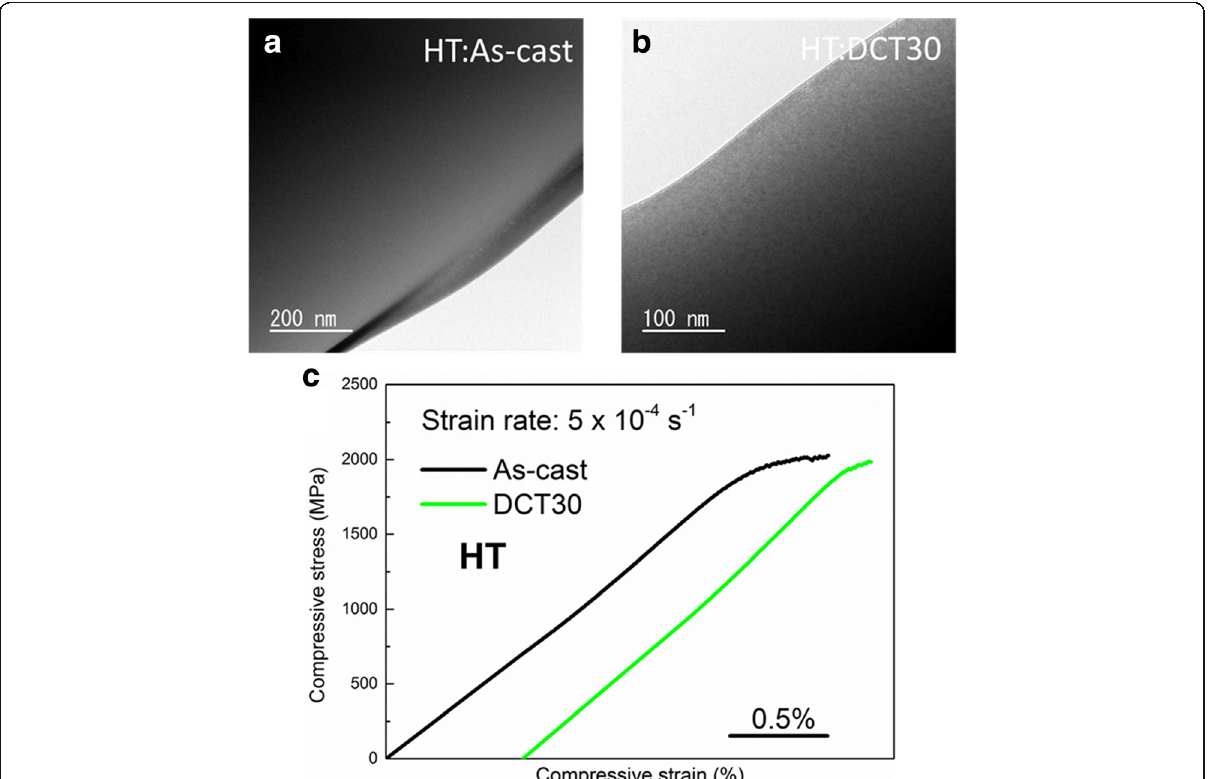
Fig. 2 a , b Bright-field TEM images of As-cast and DCT30 samples cast at HT. c Compressive stress-strain curves of As-cast and DCT30 samples cast at